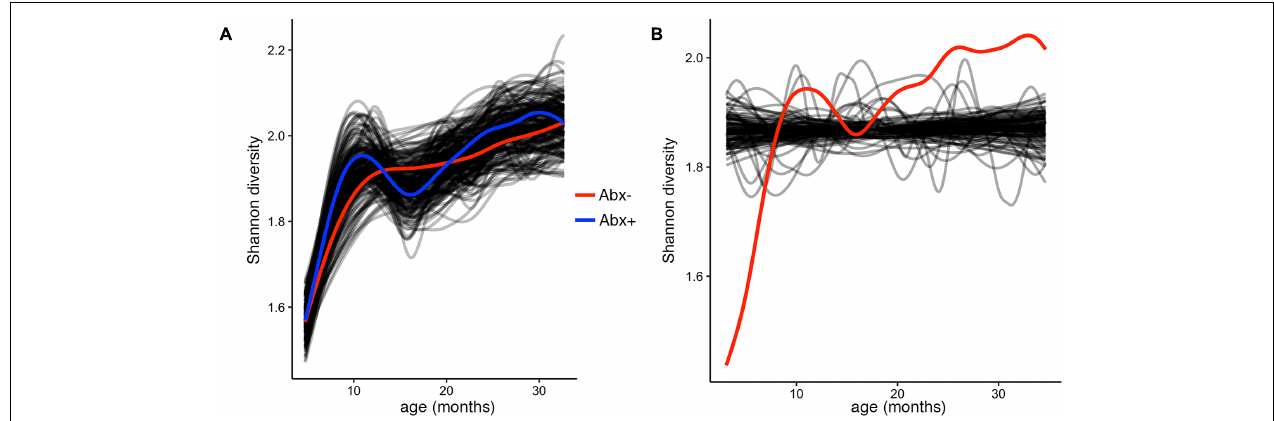
FIGURE 4 | Alpha diversity increases over time but is not different between antibiotic exposure groups. ( A ) Output plot from the permuspliner test showing that Shannon diversity is not significantly different in infants exposed to antibiotics (Abx+, blue) compared to those who were not (Abx–, red), p = 0.96. (B) The results plot from the trendyspliner function shows that the permuted data form a zero-change distribution from which the real data (red line) is significantly distinct ( p = 0.001). This supports the hypothesis that alpha diversity increases over time in the first 3 years of the infants’